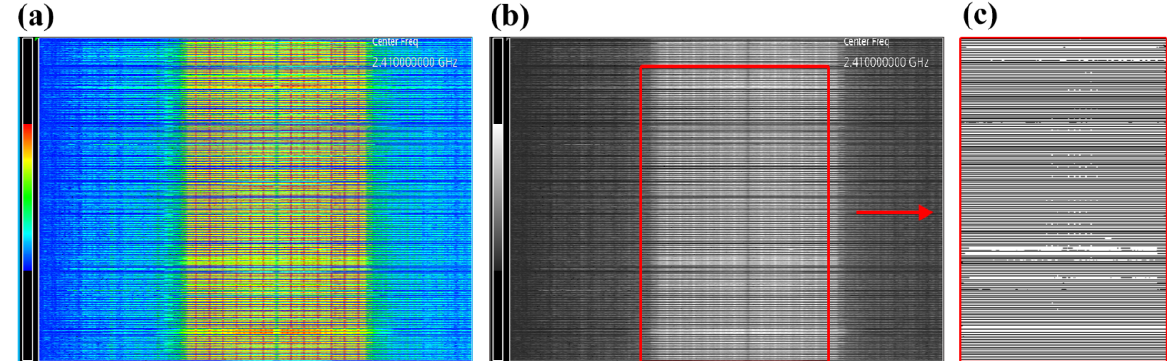
Figure 9. Stages of spectrogram image analysis: ( a ) input image, ( b ) grayscale image, ( c ) image after thresholding.